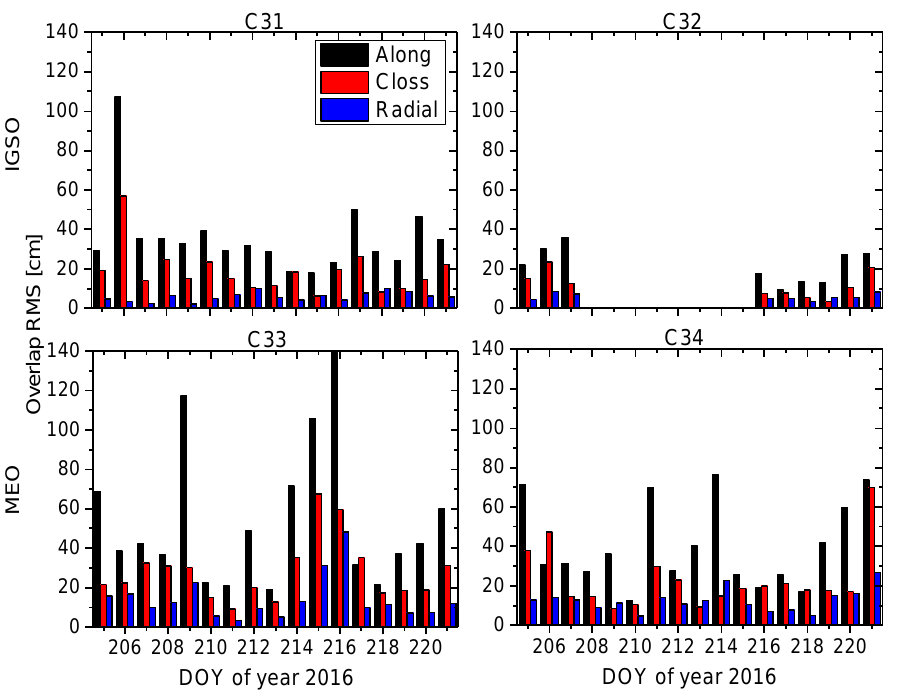
Figure 7. RMS values of 48-h orbit overlap errors for four BDS-3 satellites in along-track, across-track, and radial directions during the period of the experiment.